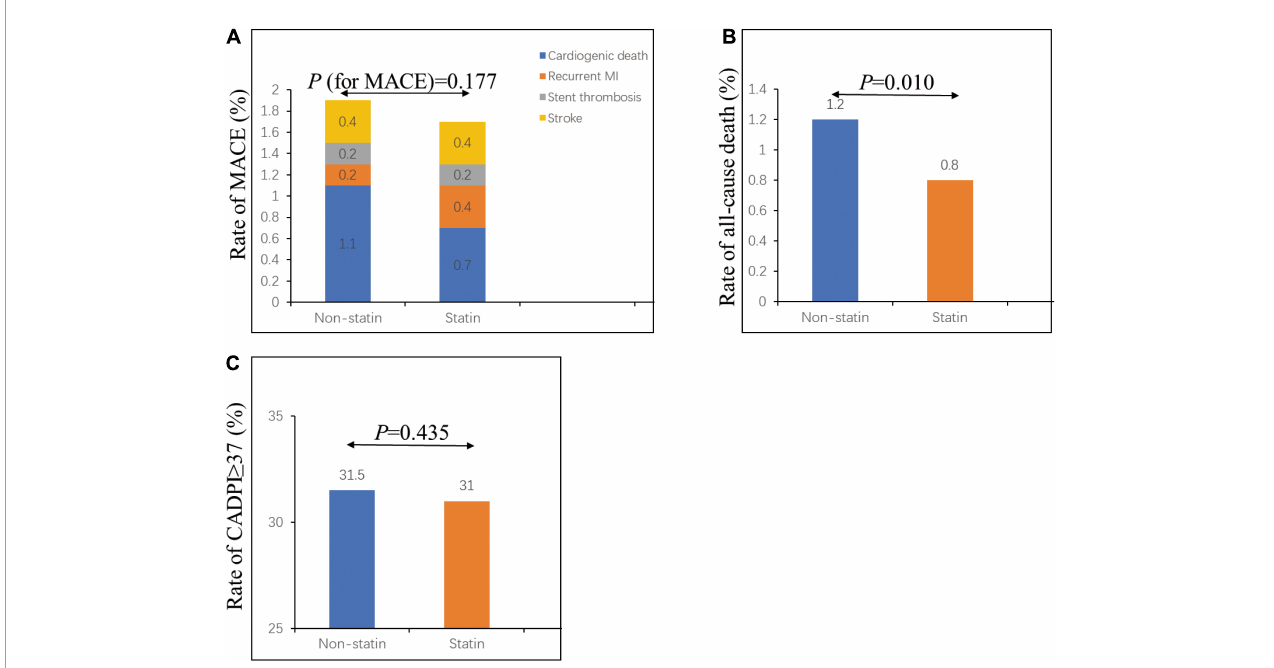
FIGURE1 In-hospital outcomes and severely obstructive CAD (CADPI ≥ 37) in patients with first ACS. (A) Rate of in-hospital MACE in the non-statin and statin groups. (B) Rate of in-hospital all-cause death in the non-statin and statin groups. (C) Rate of CADPI ≥ 37 in the non-statin and statin groups. CADPI, coronary artery disease prognostic index; MACE, major adverse cardiovascular event. A value of P < 0.05 was considered statistically